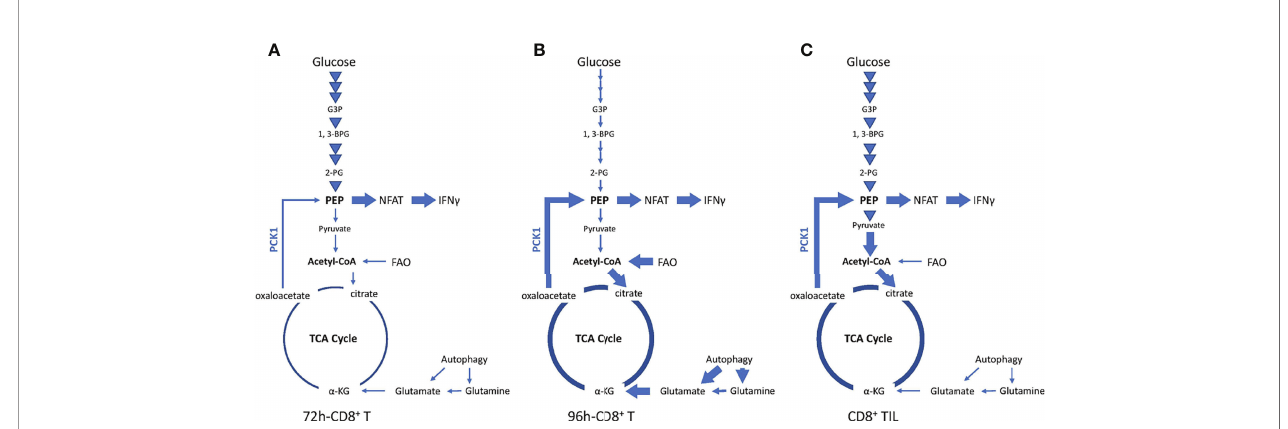
FIGURE 7 | Metabolic preference of in vitro activated CD8 + T cells and CD8TILs for Met-induced enhancement of IFN g production. (A) In vitro activated CD8 + T cells at 72 h exclusively depends on glycolysis. (B) In vitro activated CD8 + T cells at 96 h depends on FAO, glutaminolysis/autophagy, and PCK1. (C) CD8TILs depends on anaplerosis from glucose metabolism